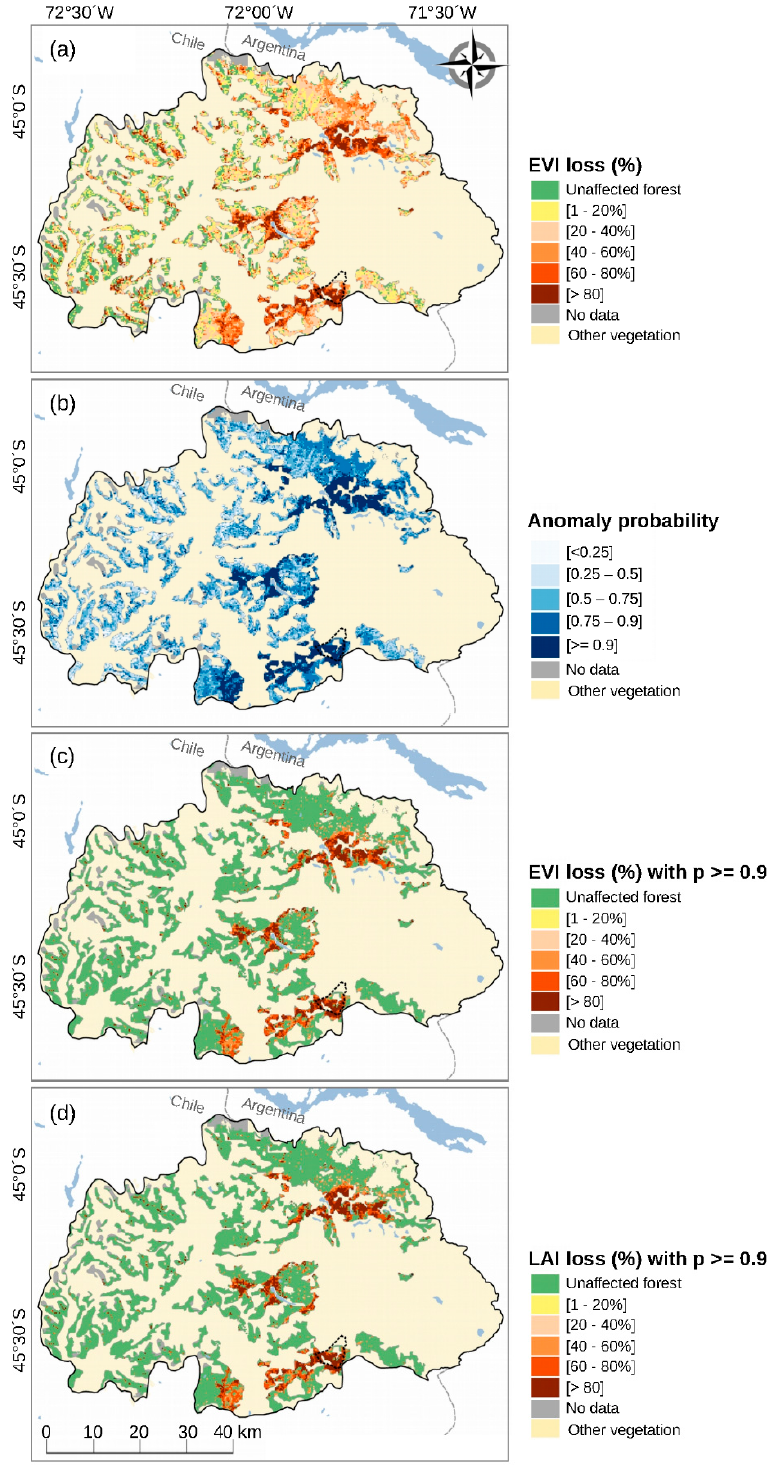
Figure 5. Maps displaying the level of forest defoliation caused by O. amphimone caterpillars at the end of the summer (DGS 268, 21 March 2016). ( a ) EVI loss (%) before the anomaly probability band is used to mask out “non-significant” values; ( b ) anomaly probability map; ( c ) EVI loss (%) with anomaly probability ≥ 0.9; ( d ) LAI loss with anomaly probability ≥ 0.9.